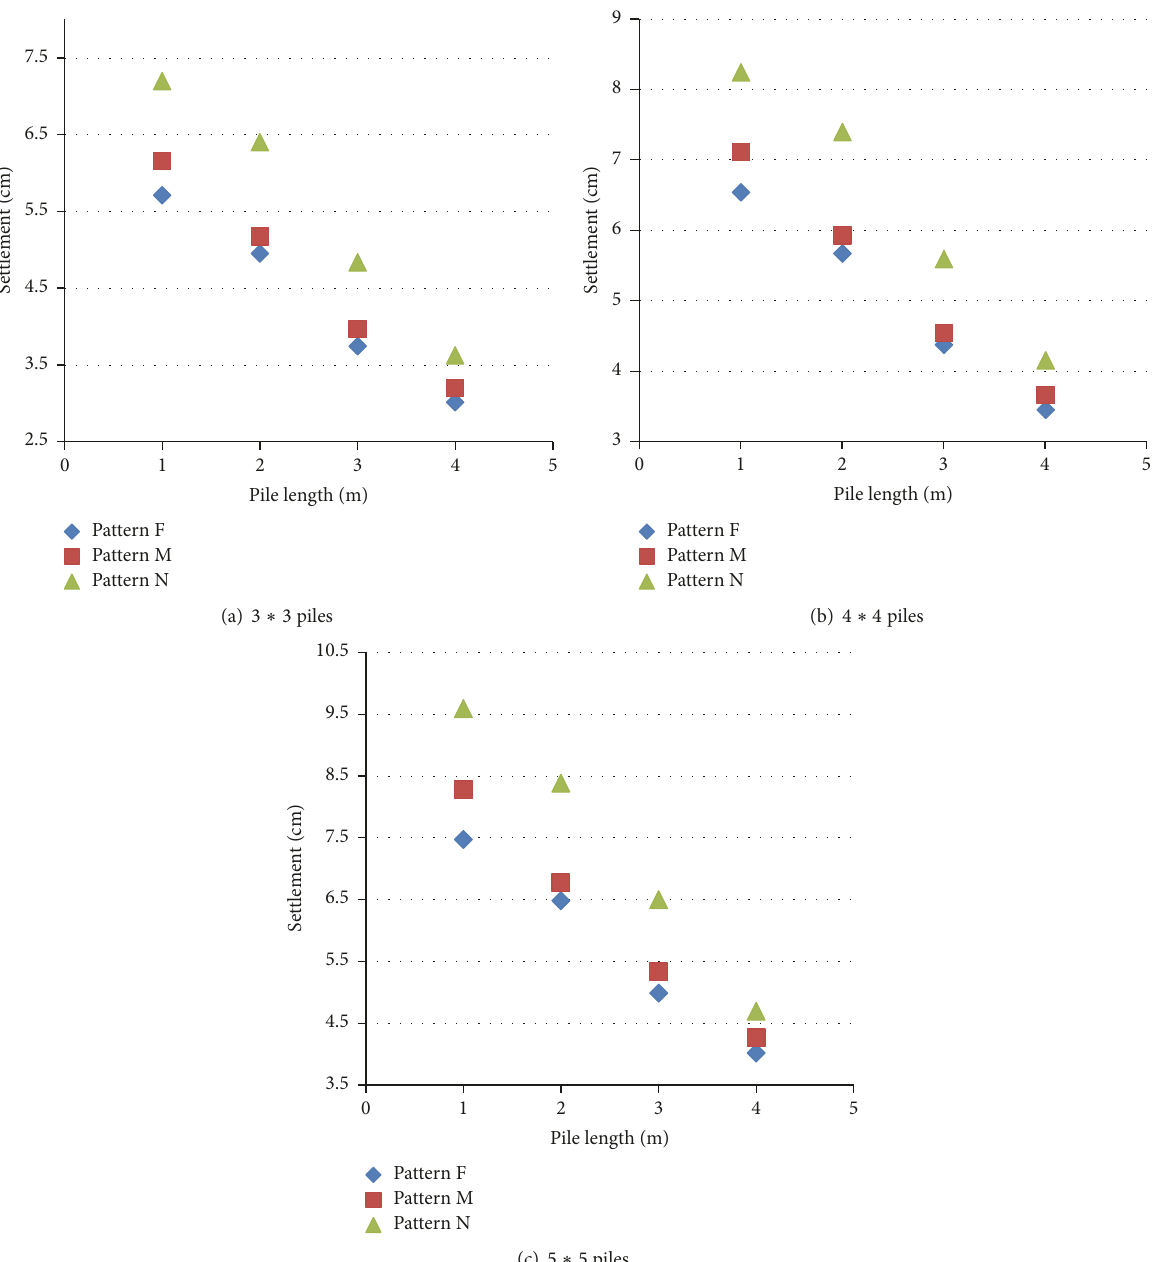
Figure 12: Effect of piles’ architecture on the coupled static-dynamic settlements of CPRF ( 𝑑 = 0.5 m, 𝑝 = 60kPa).